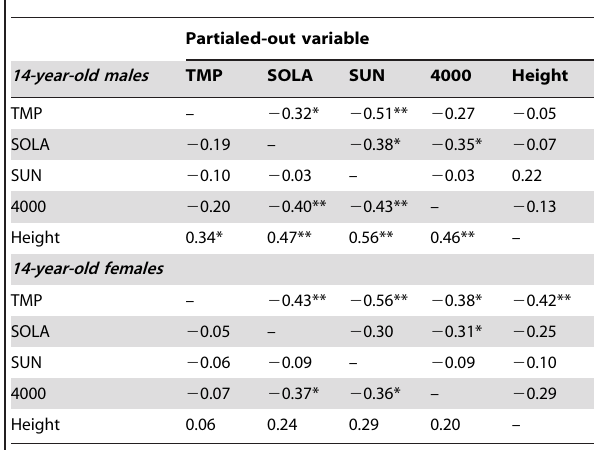
Table 6. Partial correlation coefficients of the relationship between height and climatic variables on the basis of sex.